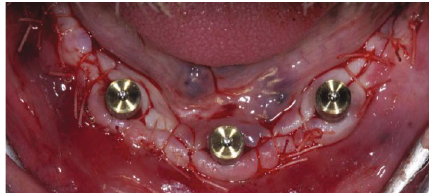
Figure 6: The surgical fl ap is sutured around the healing